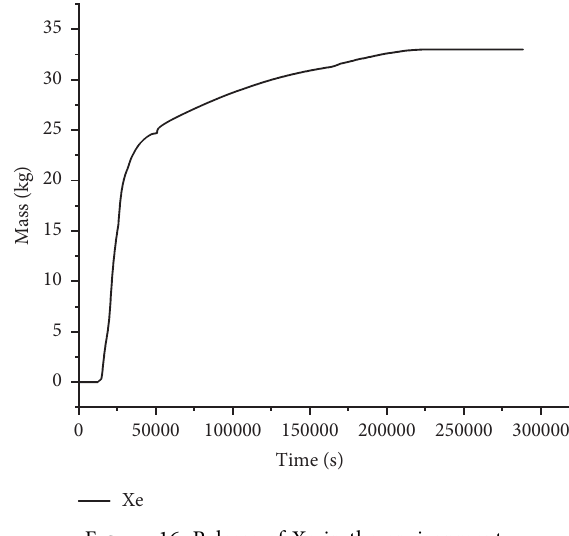
Figure 16: Release of Xe in the environment.